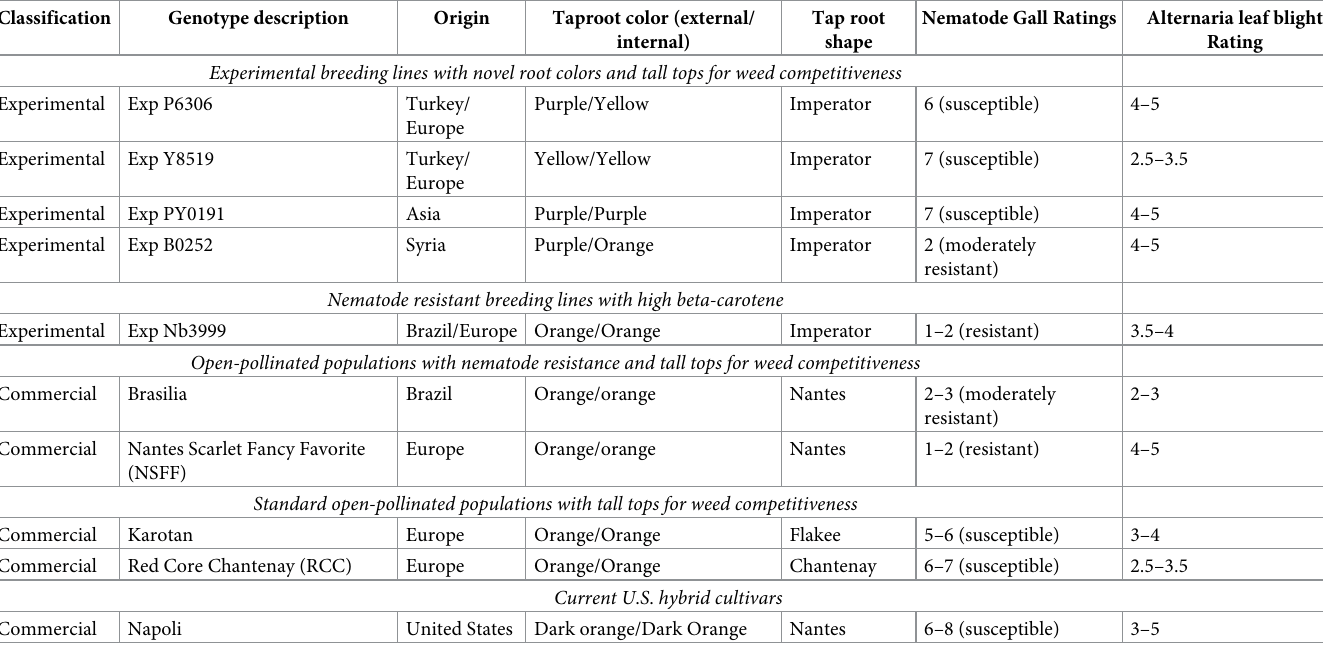
Table 1. Carrot genotypes grown in conventional and organically managed systems at Purdue’s Meigs Farm during summer